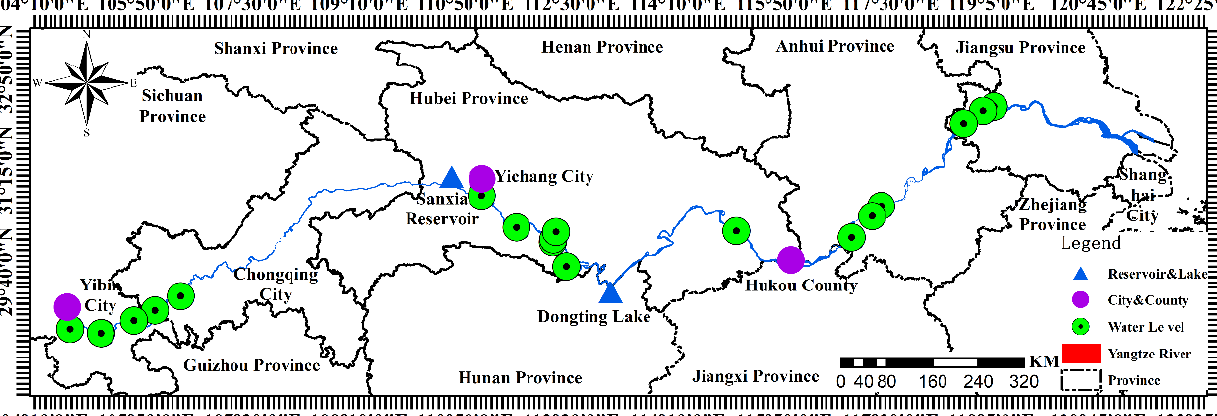
Figure 1. Study area.